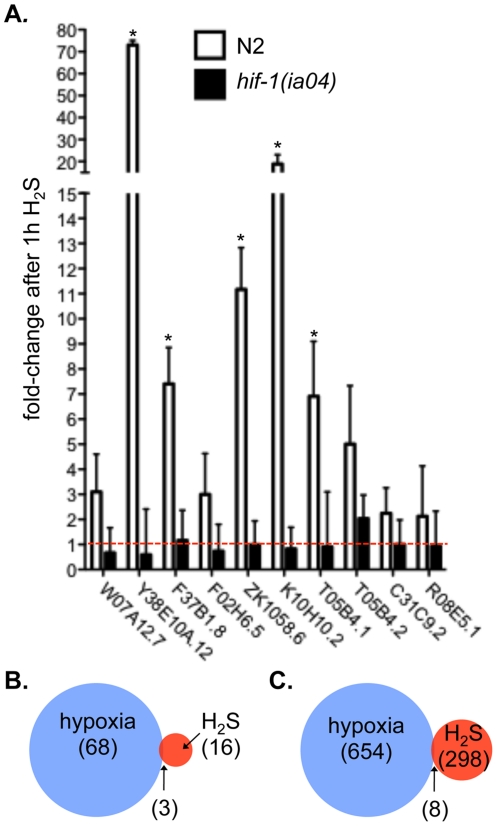
HIF-1 is required for early transcriptional responses to H2S.A. H2S-induced transcriptional changes require HIF-1. Changes in mRNA abundance after 1 h exposure to H2S were measured by qRT-PCR in wild-type (N2, open bars) and hif-1(ia04) mutant animals (filled bars). Three biological replicates for each group were performed, and each PCR reaction was run in duplicate. Error bars represent the standard deviation of the biological replicates, as propagated through the ΔΔCt and fold-change calculations. *Difference between induction in wild-type (N2) is statistically different than in hif-1(ia04) mutant animals, p<0.05. Red dashed line demarks where transcript levels in H2S are the same as in room air. B. Transcriptional changes after 1 h exposure to H2S overlap slightly with hif-1-dependent changes in response to hypoxia. 3 of 16 transcripts upregulated in response to 1 h exposure to H2S were identified as hif-1-dependent targets in hypoxia (n = 68) [15]. The probability of observing this overlap randomly is 0.001. C. There is minimal overlap between the transcriptional responses to hydrogen sulfide and hypoxia. Venn diagram shows overlap between genes induced by exposure to 12 h H2S (n = 298) and all genes products that are altered by hypoxia (n = 654) [15]. The probability of randomly observing an overlap of 8 genes between these datasets is 0.006.